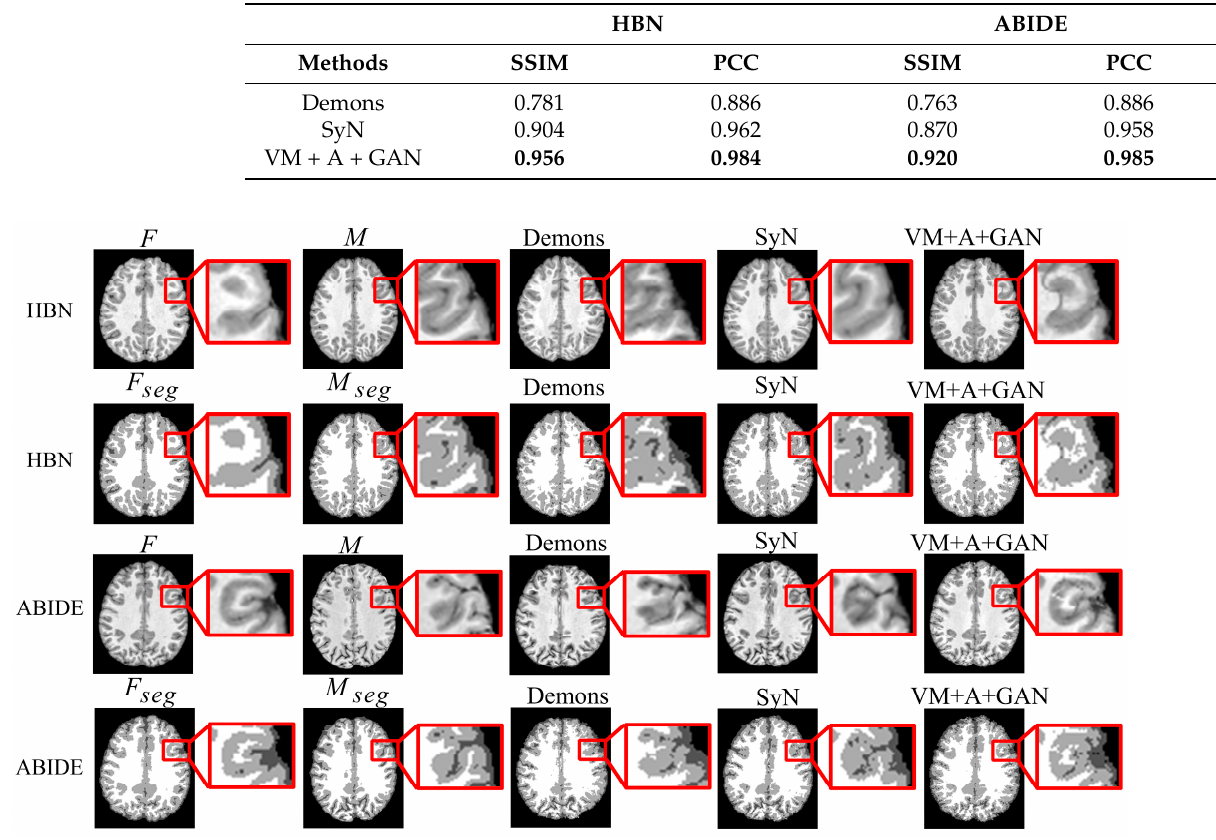
Figure 3. Registration results of Demons, SyN, and our proposed method using HBN and ABIDE